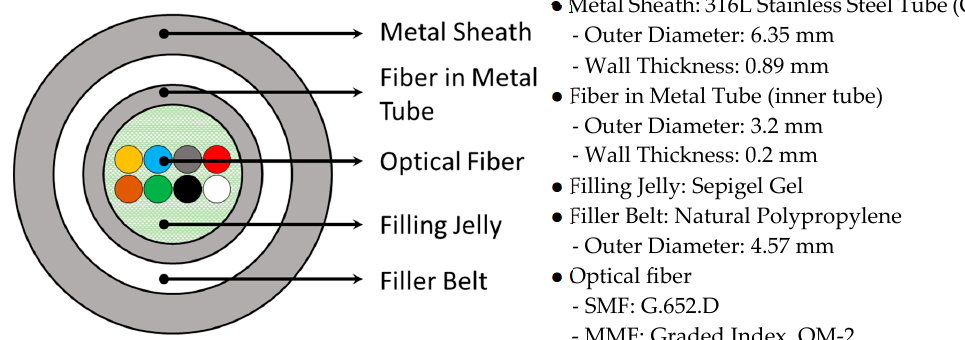
Figure 5. Optical fiber cable specifications.